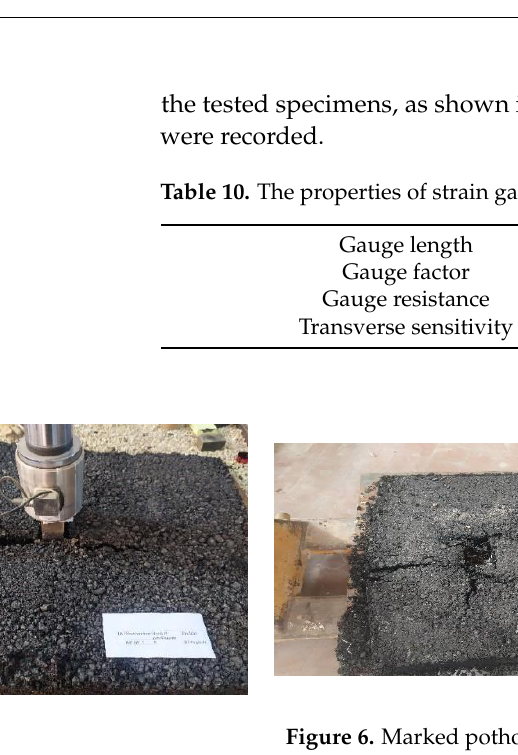
Table 10. The properties of strain gauges used.